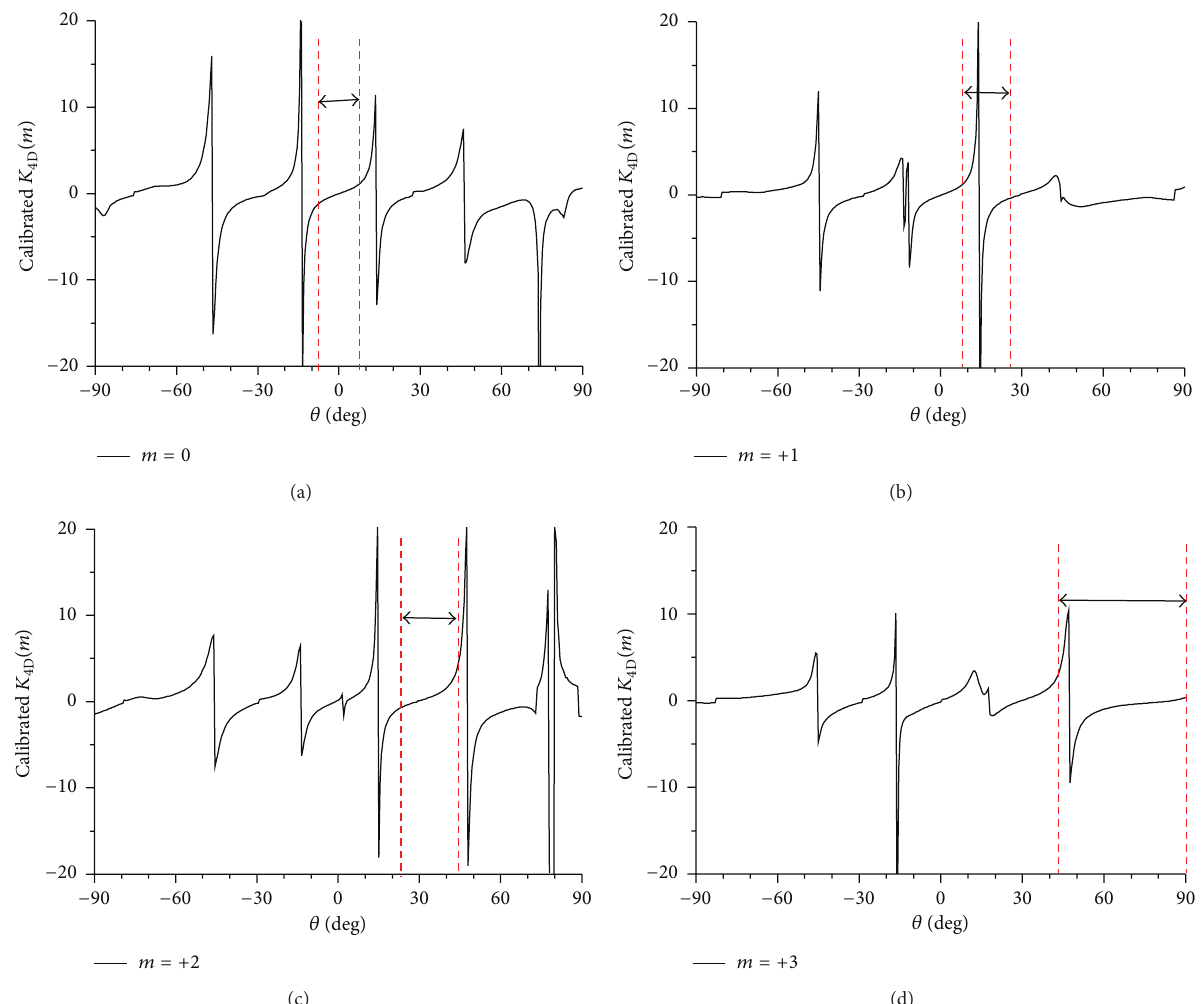
(𝑚) based on measured active element patterns. D